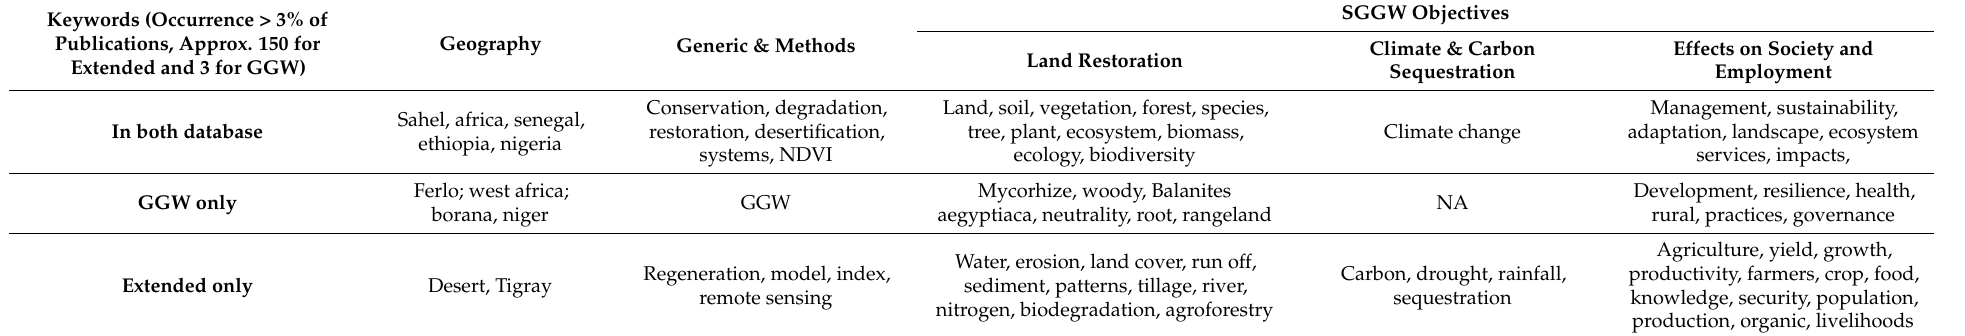
Table 2. Keywords found in both databases with occurrence > 3% of publications. Keywords (Occurrence > 3% of Publications, Approx. 150 for Extended and 3 for